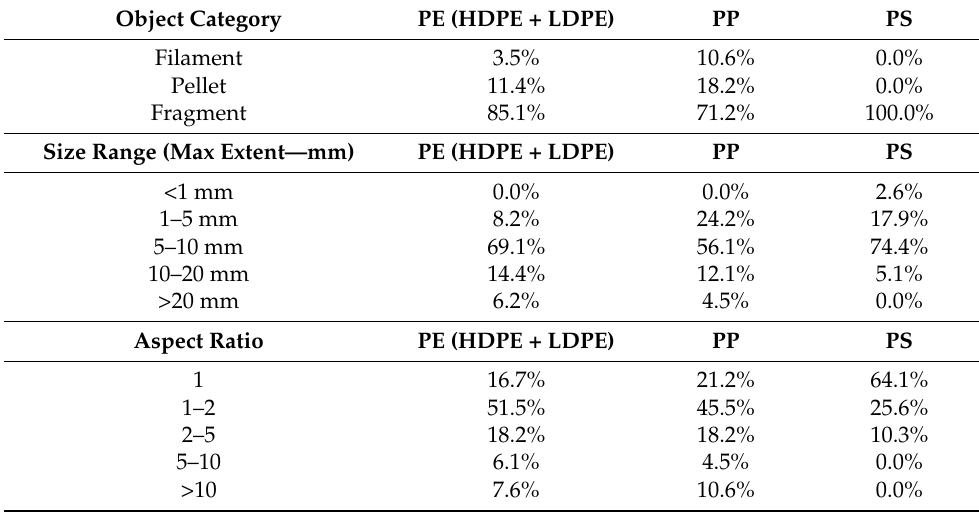
Table 2. Categories, sizes and aspect ratios of the collected plastics, organized by sample composition (three most abundant polymers found: PE, PP and